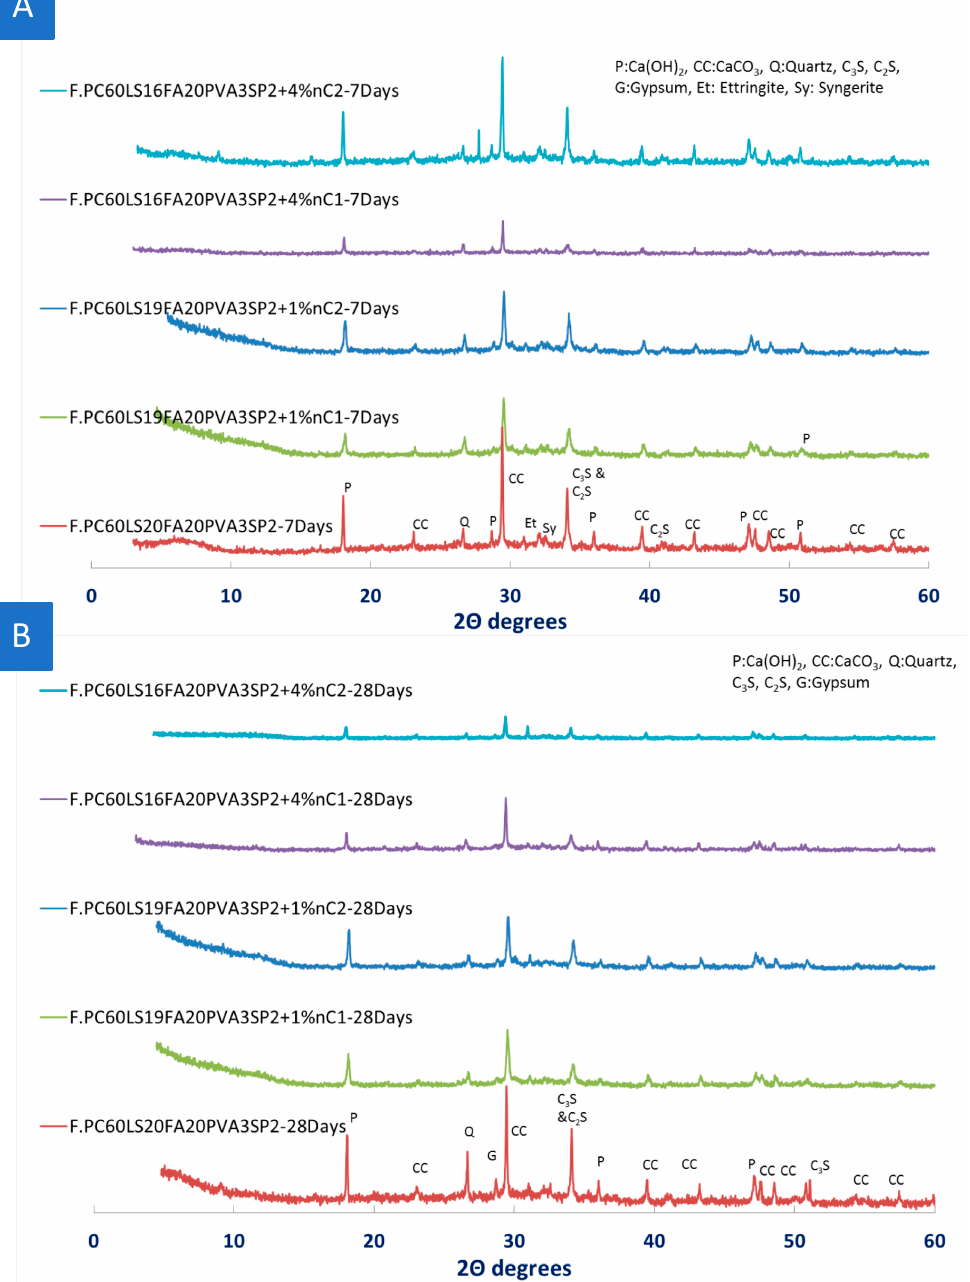
Figure 11. XRD pattern of nMt and fibre reinforced cementitious nanocomposites at ( A ) Day 7 and ( B ) at Day 28—Effect of nC content and type.